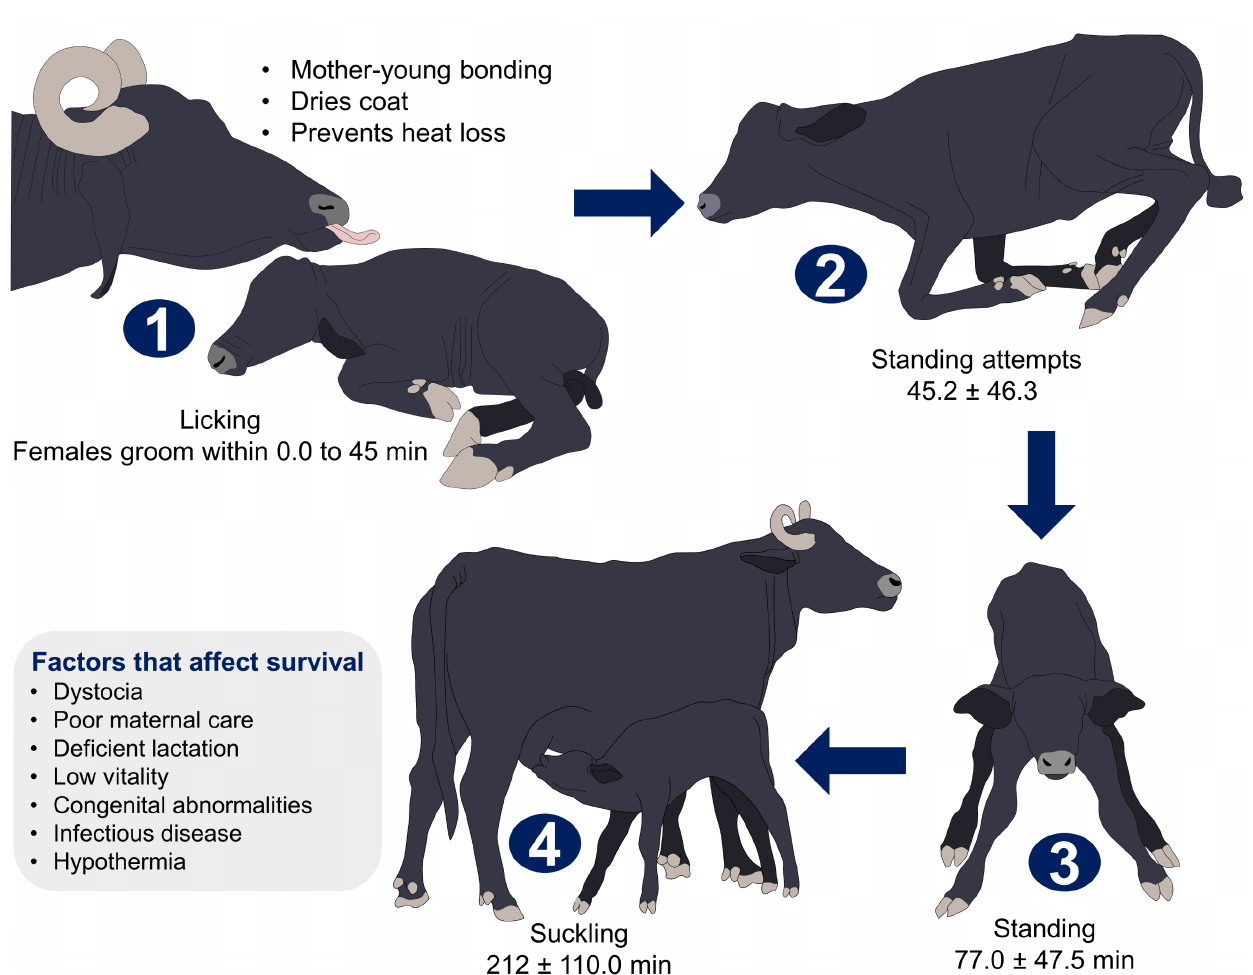
Figure 4. Factors affecting neonatal survival and characteristics of newborn calves during the first hours of life. The sequence of post-birth behaviors of the calf are numbered inside the figure, where the licking and grooming of the dam encourages the newborn to stand up and suckle. Under normal conditions, the offspring follows this pattern. However, factors such as dystocia, poor maternal care, and hypothermia, among others, can affect calf’s survival.